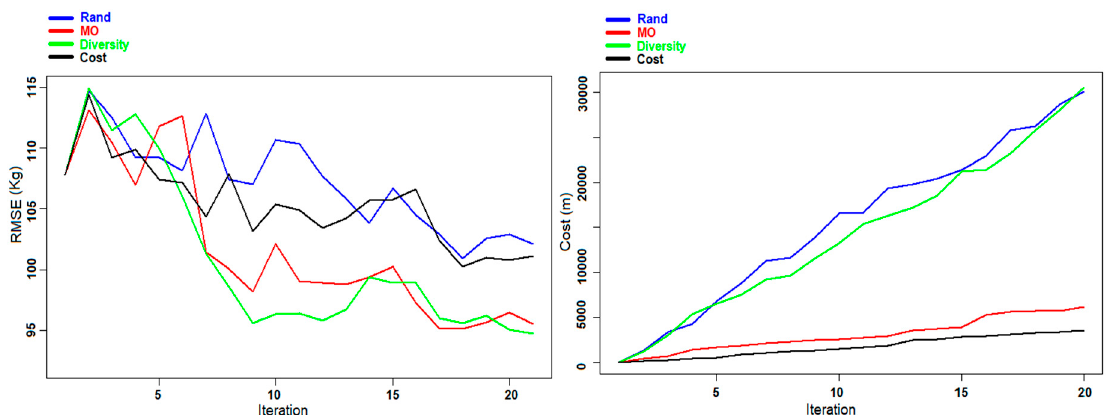
Figure 5. Experiment A: Evolution of the RMSE ( left panel ) and the cost ( right panel ) for DBH prediction for the Våler dataset during the different iterations.